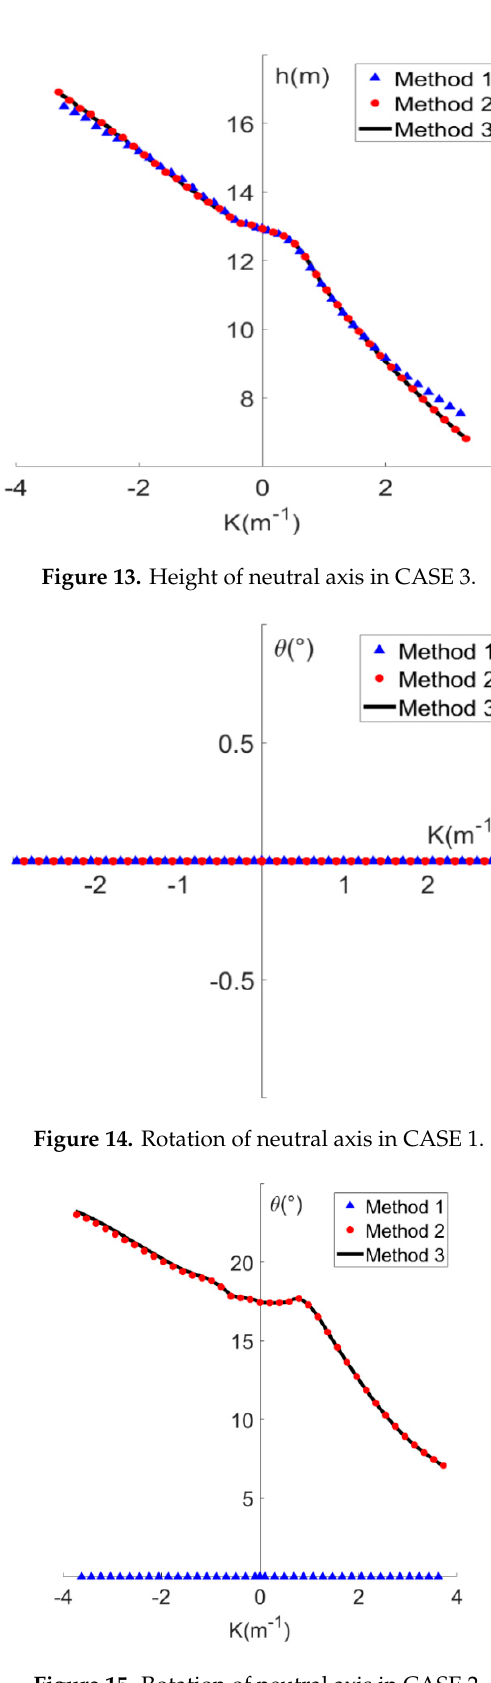
Figure 16. Rotation of neutral axis in CASE 3. Table 5. Comparison of ultimate strength obtained by different contributors. Source